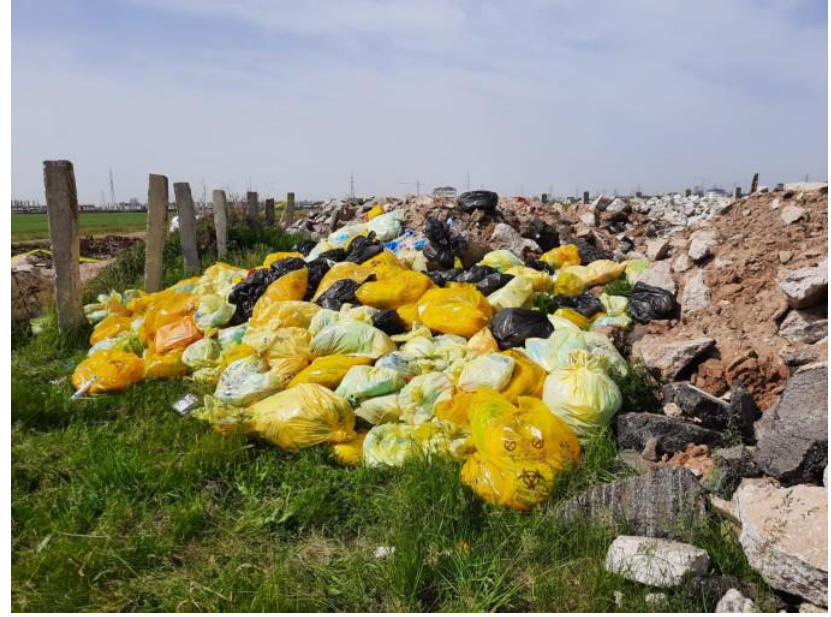
Figure 5. Illegal dumping of medical waste in Dobroiesti commune, Ilfov County. 14 May 2020 (source: National Environmental Guard).